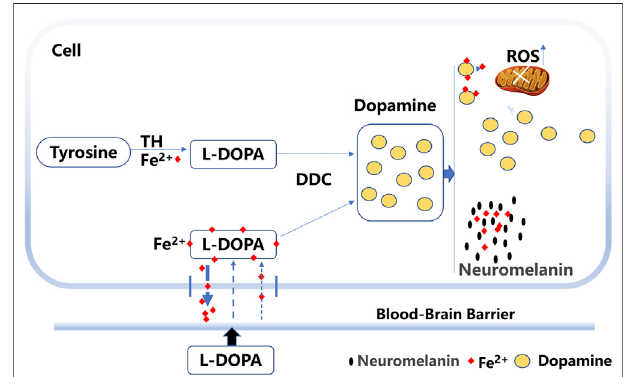
FIGURE 9 | Probable mechanism for the effects of levodopa on iron deposition. Levodopa (L-DOPA) can cross the blood barrier and form a stable complex through binding to iron. The levodopa – iron complex facilitates iron transport out of cells. Excess dopamine is converted to neuromelanin and enhances the binding of neuromelanin to iron. Levodopa treatment also induced the production of reactive oxygen species (ROS).